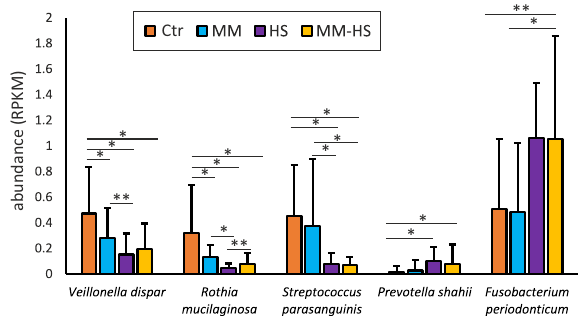
Fig. 4 Halitosis and halitosis-free bacterial biomarkers. The bar graphs show bacteria with a signi fi cant difference in abundance in the metatranscriptome between control and halitosis patients, which could serve as potential biomarkers of health and halitosis in tongue bio fi lms. Three potential halitosis-free biomarkers ( V. dispar , R. mucilaginosa and S. parasanguinis ) and two potential halitosis biomarkers ( P. shahii and F. periodonticum ) are plotted for each identi fi ed group. RPKM: Number of mRNA reads normalized by gene length (Kbp) and by sequence coverage (Mbp). * p < 0.05 (DESeq2 test); ** p < 0.1 (DESeq2 test). Standard deviation was used for error